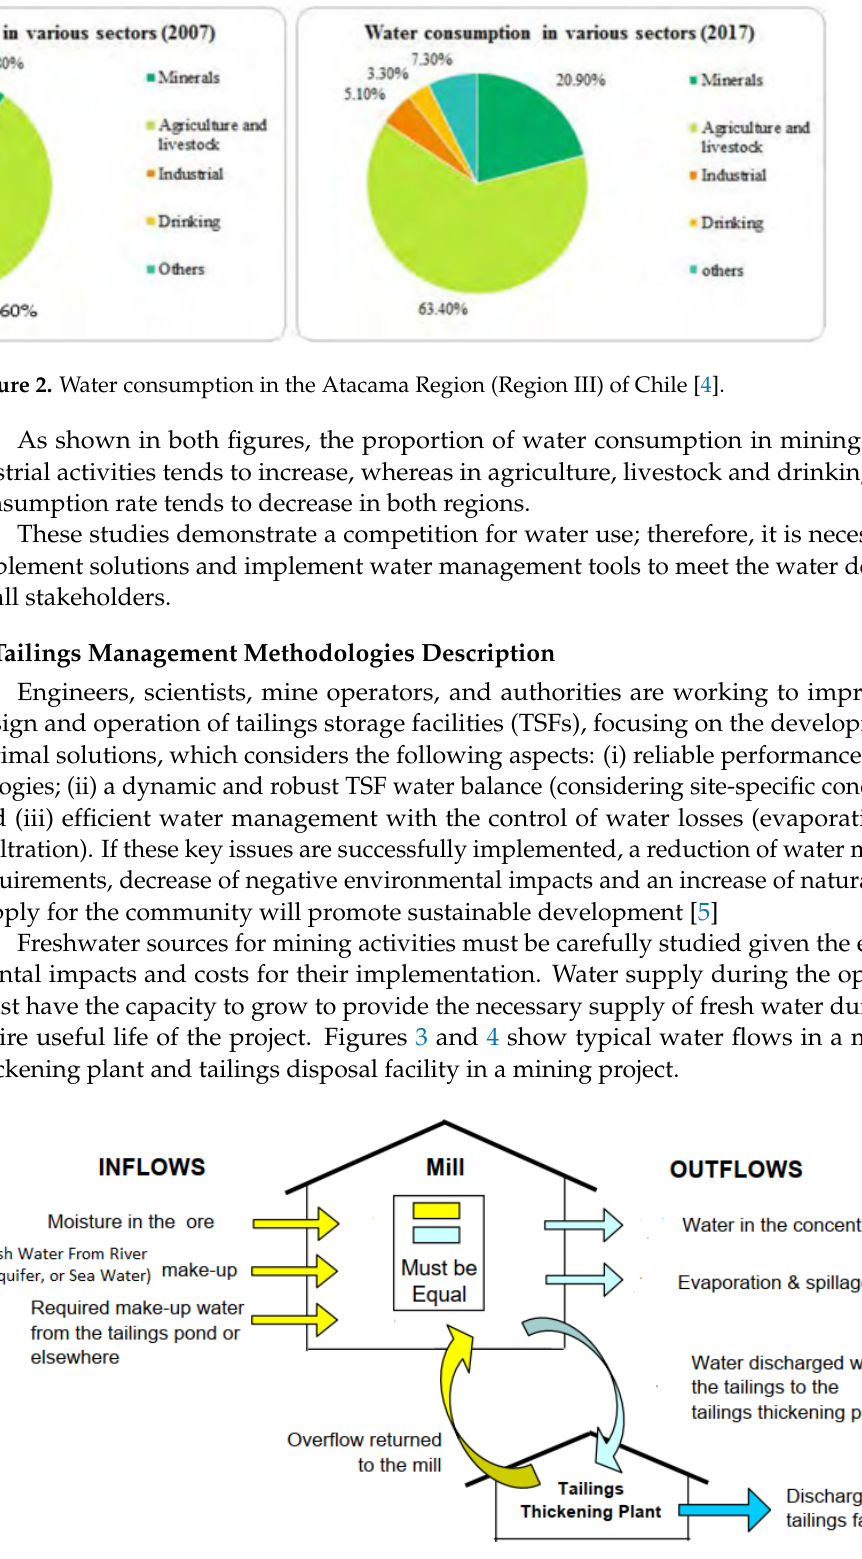
Figure 4. Typical Flows into and out of a mine tailings disposal facility. The application of tailings dewatering technologies for increasing tailings water re ‐ covery is a relevant step to reduce water losses (resource from freshwater or seawater supplies) caused by evaporation, infiltration and retention at interstitial voids on tailings storage facilities; for this reason, it is necessary to implement new designs in order to make an environmentally friendly tailings management focus on efficiency water use. Figure 5 shows different dewatering tailings technologies that focus on water recov ‐ ery and efficient water management: